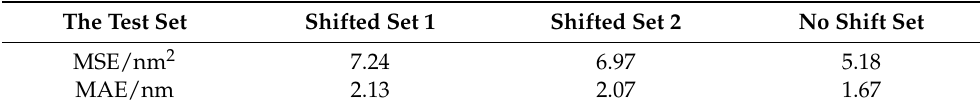
Table 3. The MSE and MAE of Focus & TSOM-CNN on two shifted gold line test sets and a no shift test